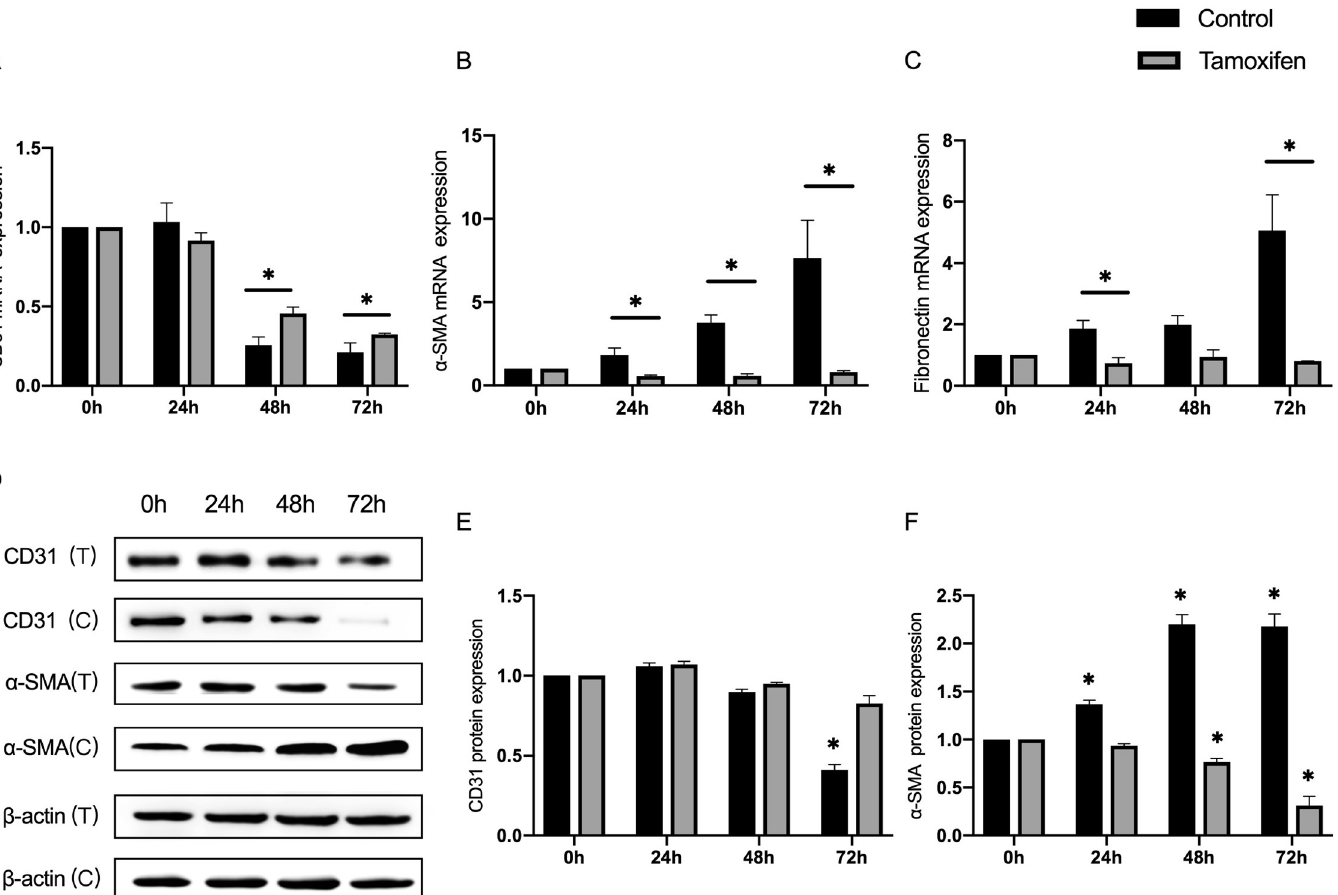
Fig 5. The hypoxia-treated ECs were incubated with tamoxifen, the HIF-1 α inhibitor, and the expression of CD31, α -SMA and fibronectin were detected. (A, B and C) The relative expression of CD31, α -SMA and fibronectin at the mRNA level. (D) Representative images from the western blot performed for the detection of CD31 and α -SMA, with and without tamoxifen treatment. (E and F) Densitometric analyses of the western blot experiments. The above experiments were repeated three times independently. The statistical differences were assessed by one-way analysis of variance (ANOVA) (Kruskal–Wallis), followed by Dunn’s posthoc test. � P < 0.05 against the untreated condition. The graph bars show the mean ± SD. The asterisk on top of the bars correlate to the 24, 48 and 72 hours, which represent the comparison with the bars of the two groups at the same time point.